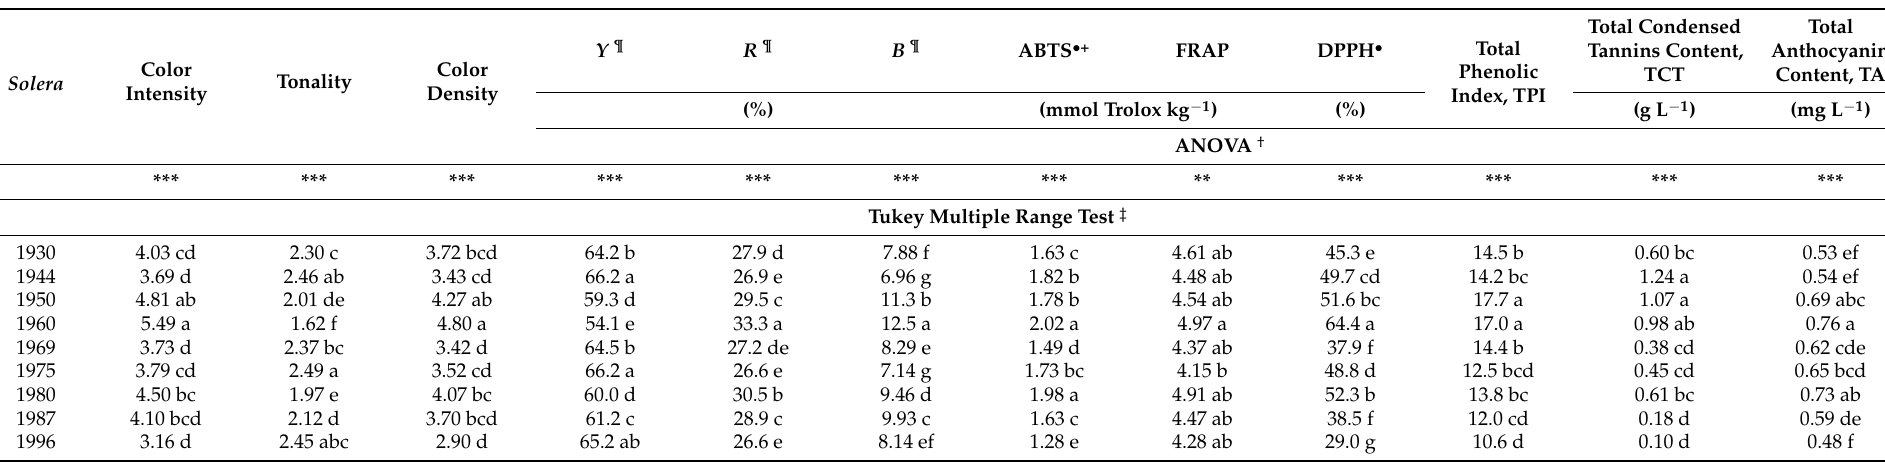
Table 2. Chromatic Characteristics, antioxidant activity, total phenolic index, and total contents of condensed tannins and anthocyanins of Fondill ó n wines as affected by the “ solera ” factor.